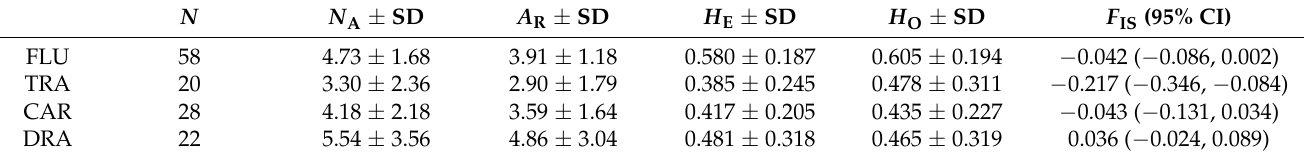
Table 1. Within-population genetic estimates in Esox spp. Summary statistics of within-population genetic variation averaged over loci for each population.